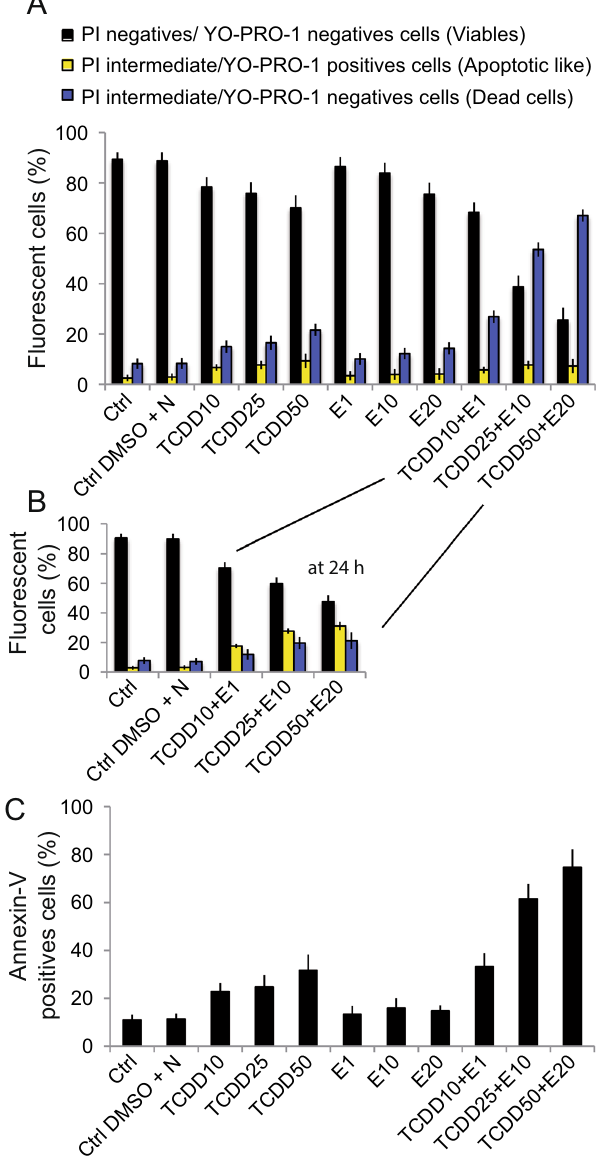
Figure 1. TCDD plus endosulfan induces cell death. ( A ) YO-PRO-1/PI staining of Caco-2 cells treated with TCDD or α -E alone or with TCDD + endosulfan mixtures for 48 h incubation. Two controls have been used: control cells (in DMEM) and control cells treated with DMSO and nonane since TCDD and E are dissolved respectively in nonane or DMSO. Each experiment has been performed each time we set flow cytometry analysis of any other parameters ( ΔΨ m, ROS, annexine V/PI measurements or caspases, cathepsin or calpain determination). So the number of experiments realized is high (n ≥ 55). ( B ) YO-PRO-1/PI staining of Caco-2 cells treated with increased amounts of TCDD + endosulfan mixtures for 24 h incubation. ( C ) Phosphatidyl serine exposure to the outer leaflet of the plasma membrane measured with annexine V-FITC with Propidium iodide (n =